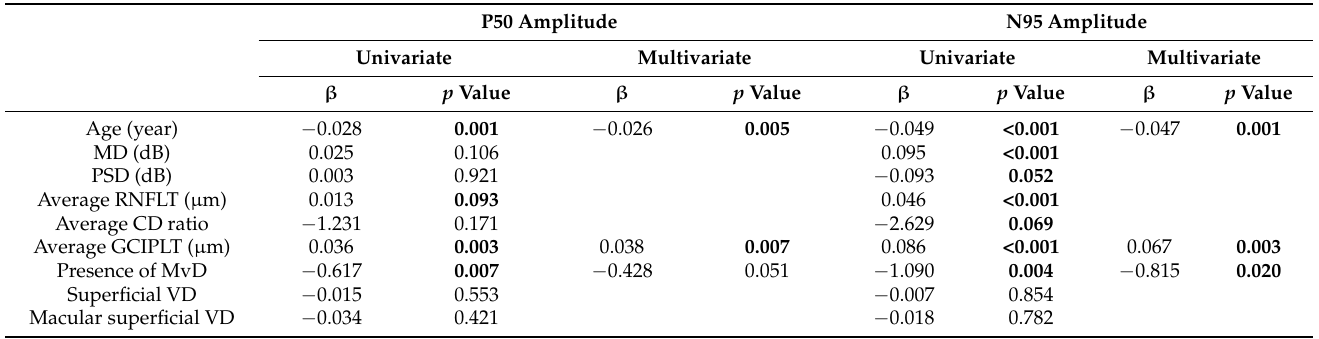
Table 5. Linear Regression Analysis evaluating the Factors associated with the Pattern Electroretino- gram